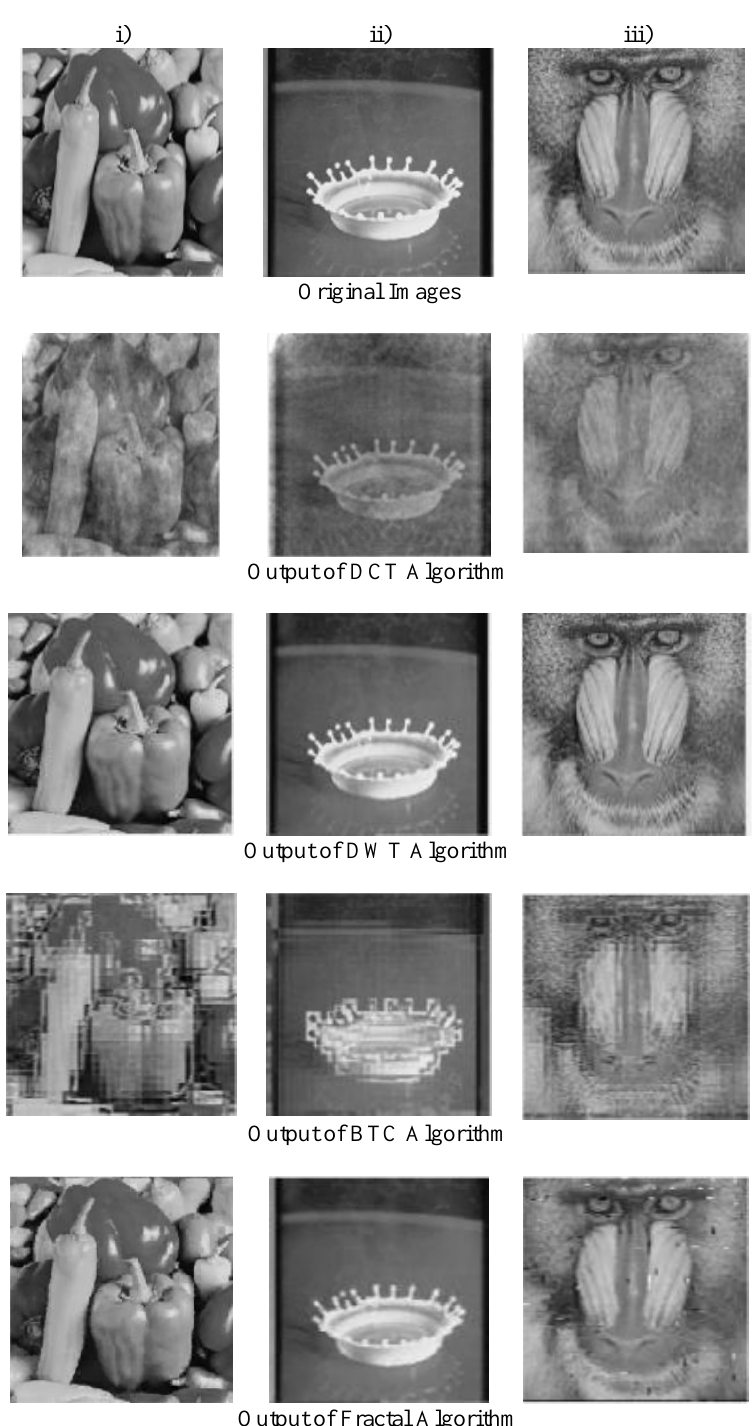
Figure 5 . Output of Images using Lossy Compression